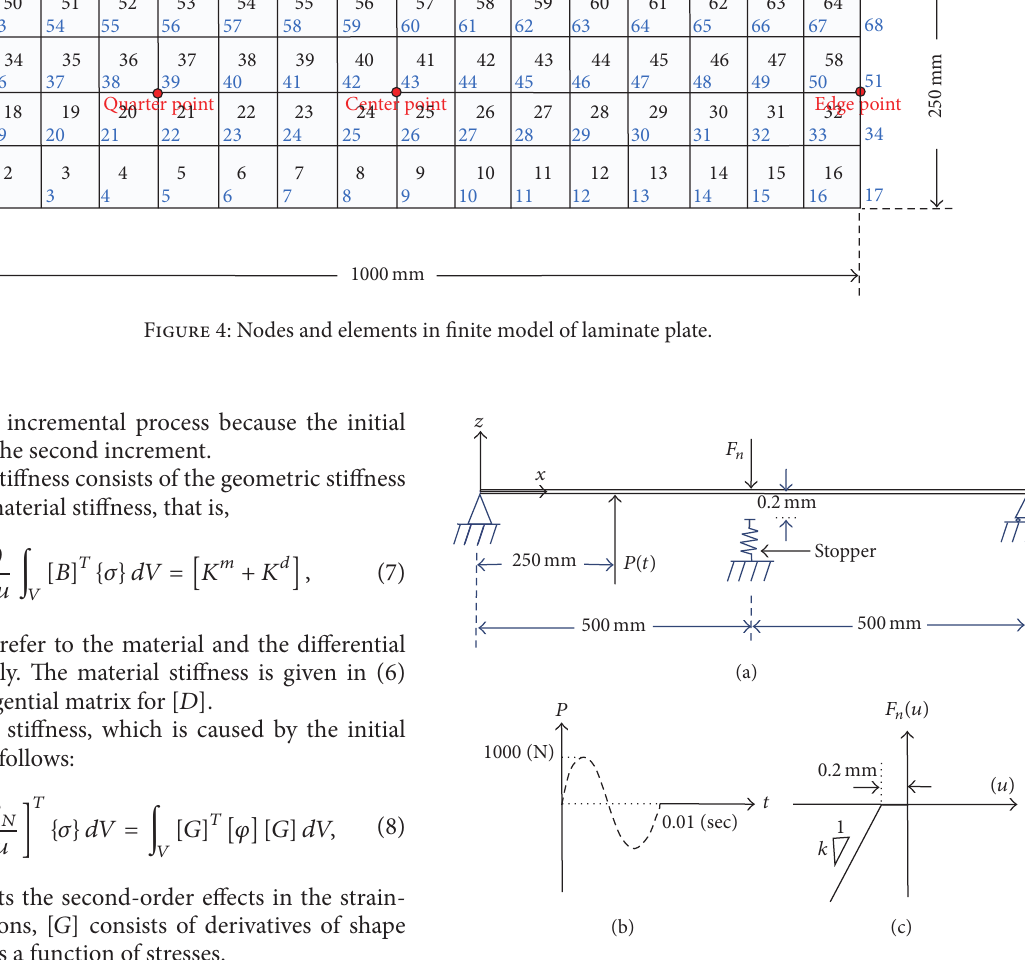
Figure 5: Simply supported plate at a couple of short edges with a gapandspringinseriesrestrainedmotion:(a)frontview;(b)forcing function; (c) gap and spring in